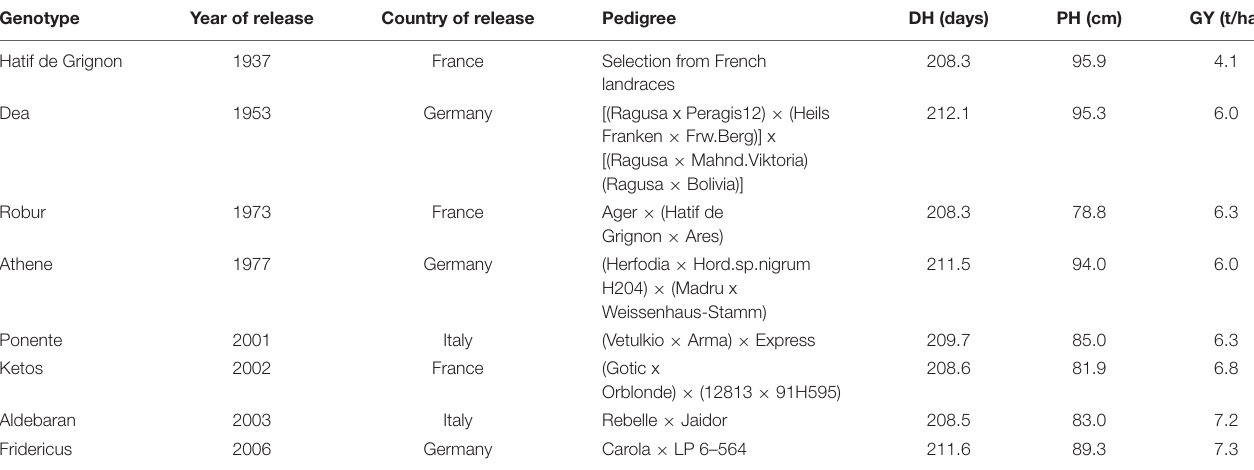
TABLE 1 | Founder set of barley varieties that were intermated for creating the barley MAGIC population.